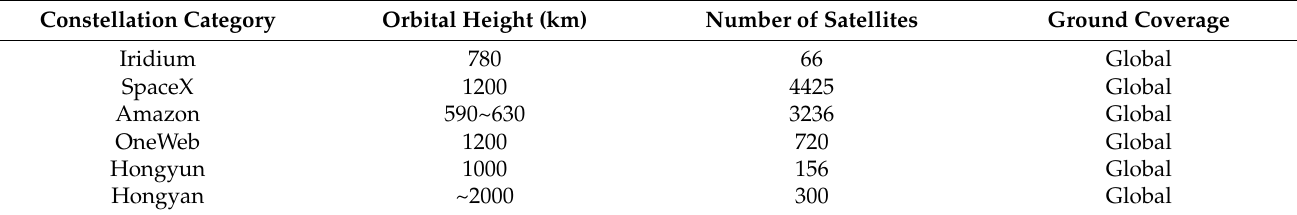
Table 2. Technical parameters of the